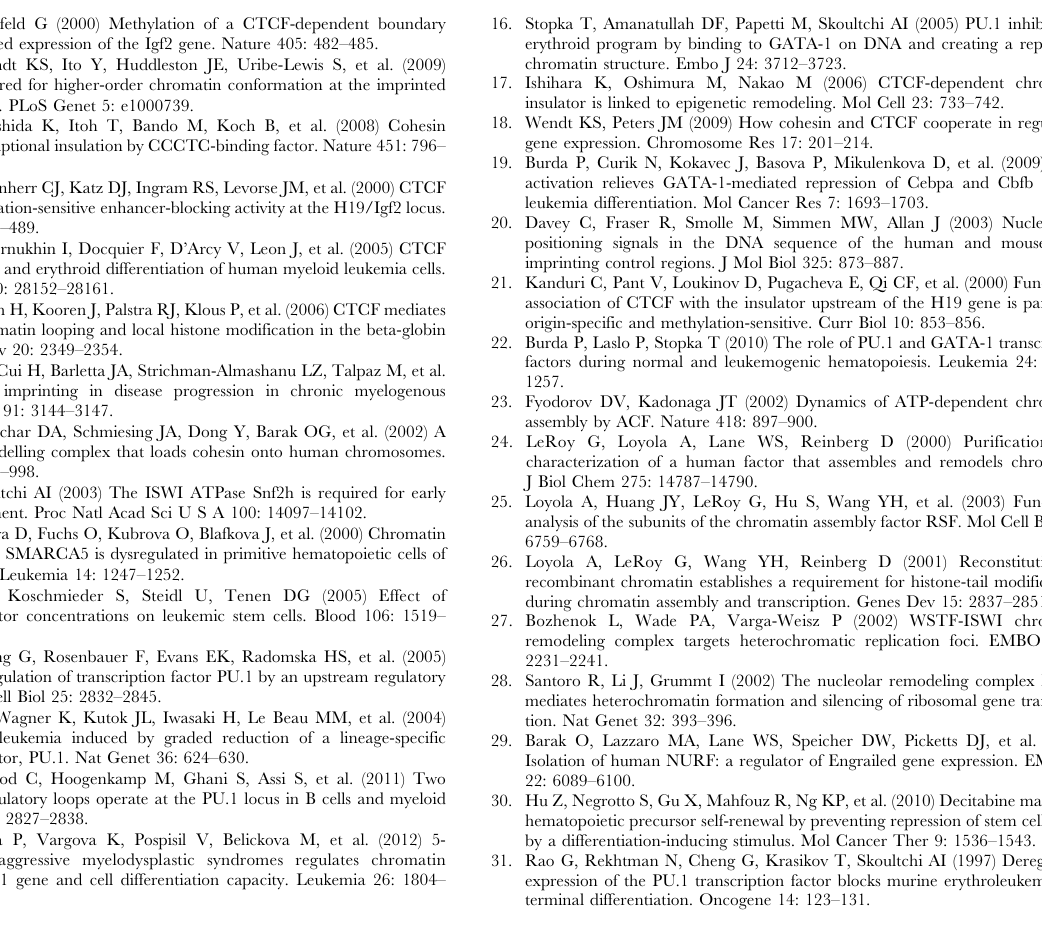
Table S1 Summary of patients. Table S2 Primer